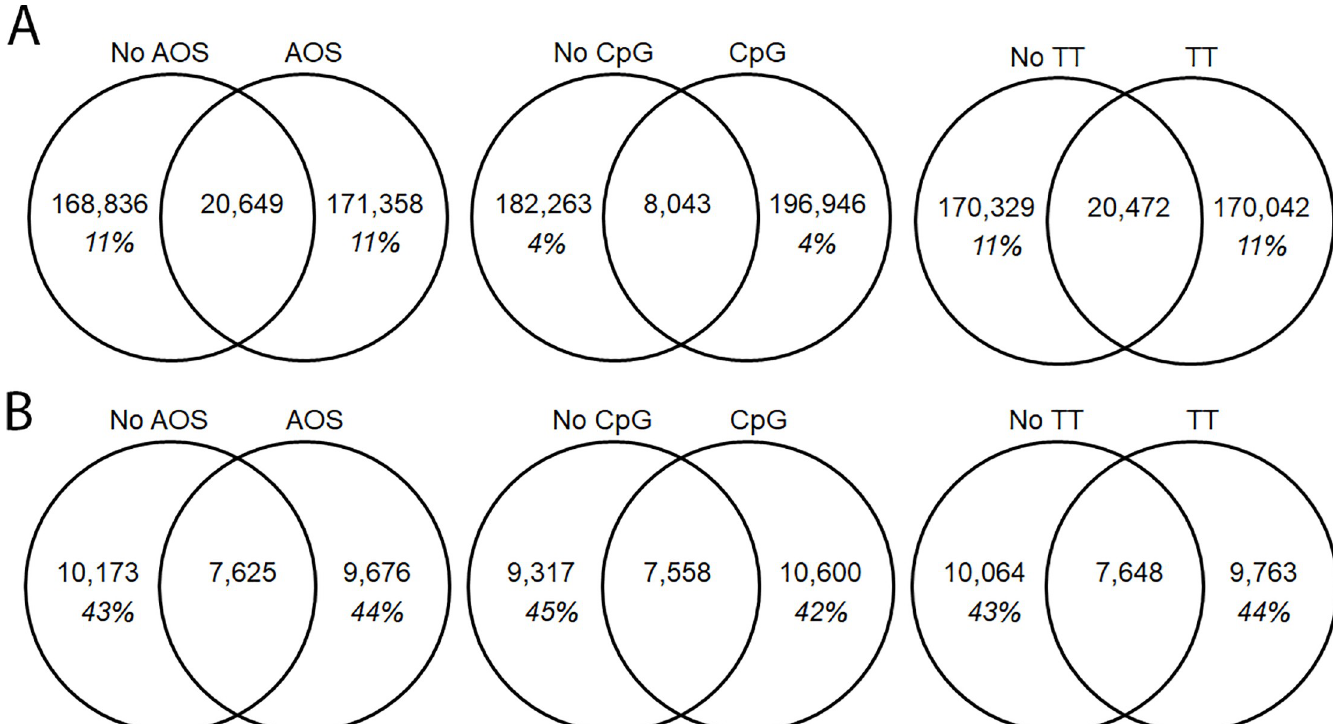
Fig 12. Overlap of Unique CDR3 Amino Acid Sequences by Variable For Heavy Chain (A) and Kappa (B) Chain. The overlap of unique CDR3 sequences is displayed in Venn Diagrams. The total number of unique CDR3s is displayed by variable group with the percent of the shared repertoire shown in italics below the number of unique amino acid